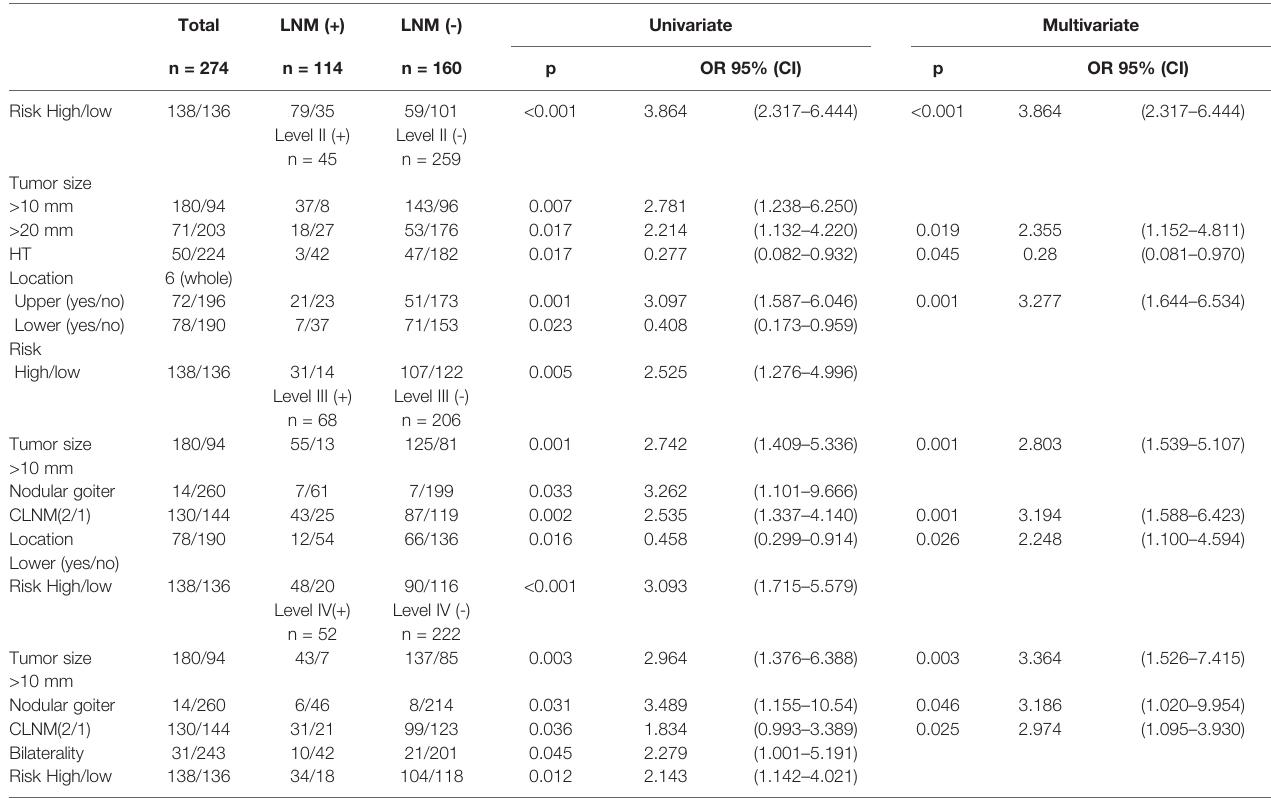
TABLE 3 | Risk factors for LLNM in the level II, III, and IV